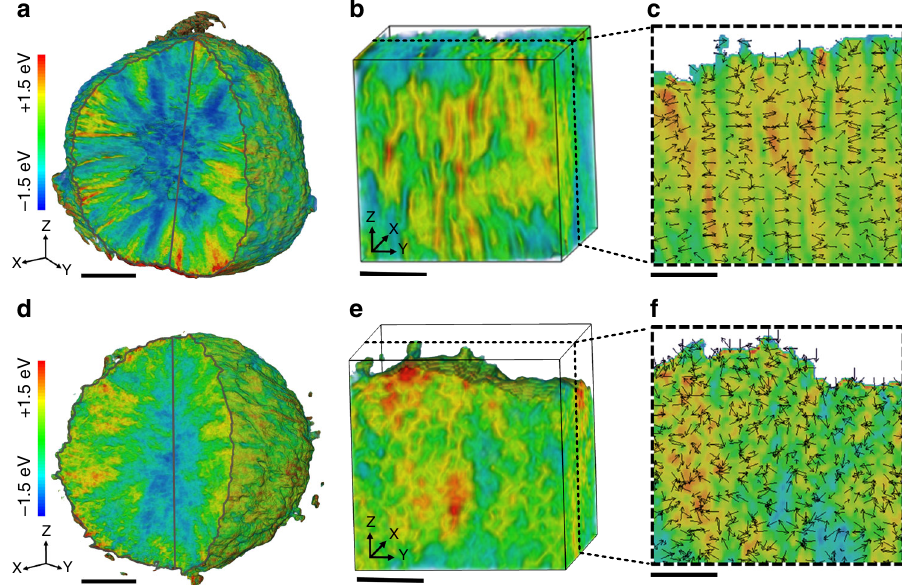
Fig. 3 Charge distributions in the fi rst charged state. a 3D Ni valence state distribution, b representative region of the 3D Ni valence state distribution, and c 2D nanodomain valence gradient of the rod-NMC. d 3D Ni valence state distribution, e representative region of the 3D Ni valence state distribution, and f 2D nanodomain valence gradient of the gravel-NMC. The nanodomain valence gradient vectors are represented by the black arrows, where the vector direction and magnitude are represented by the arrow direction and arrow length, respectively. The scale bars in ( a ) and ( d ) are 3 μ m, and the scale bars in ( b – c ) and ( e – f ) are 1 μ m. The Ni K-edge absorption energies are color-coded, in which blue stands for lower edge energy and red means higher edge